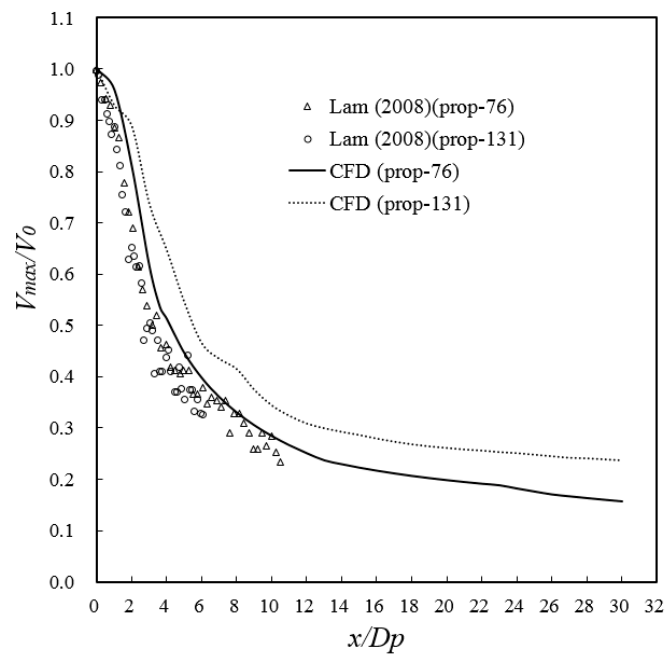
Figure 8. Axial velocity decay.